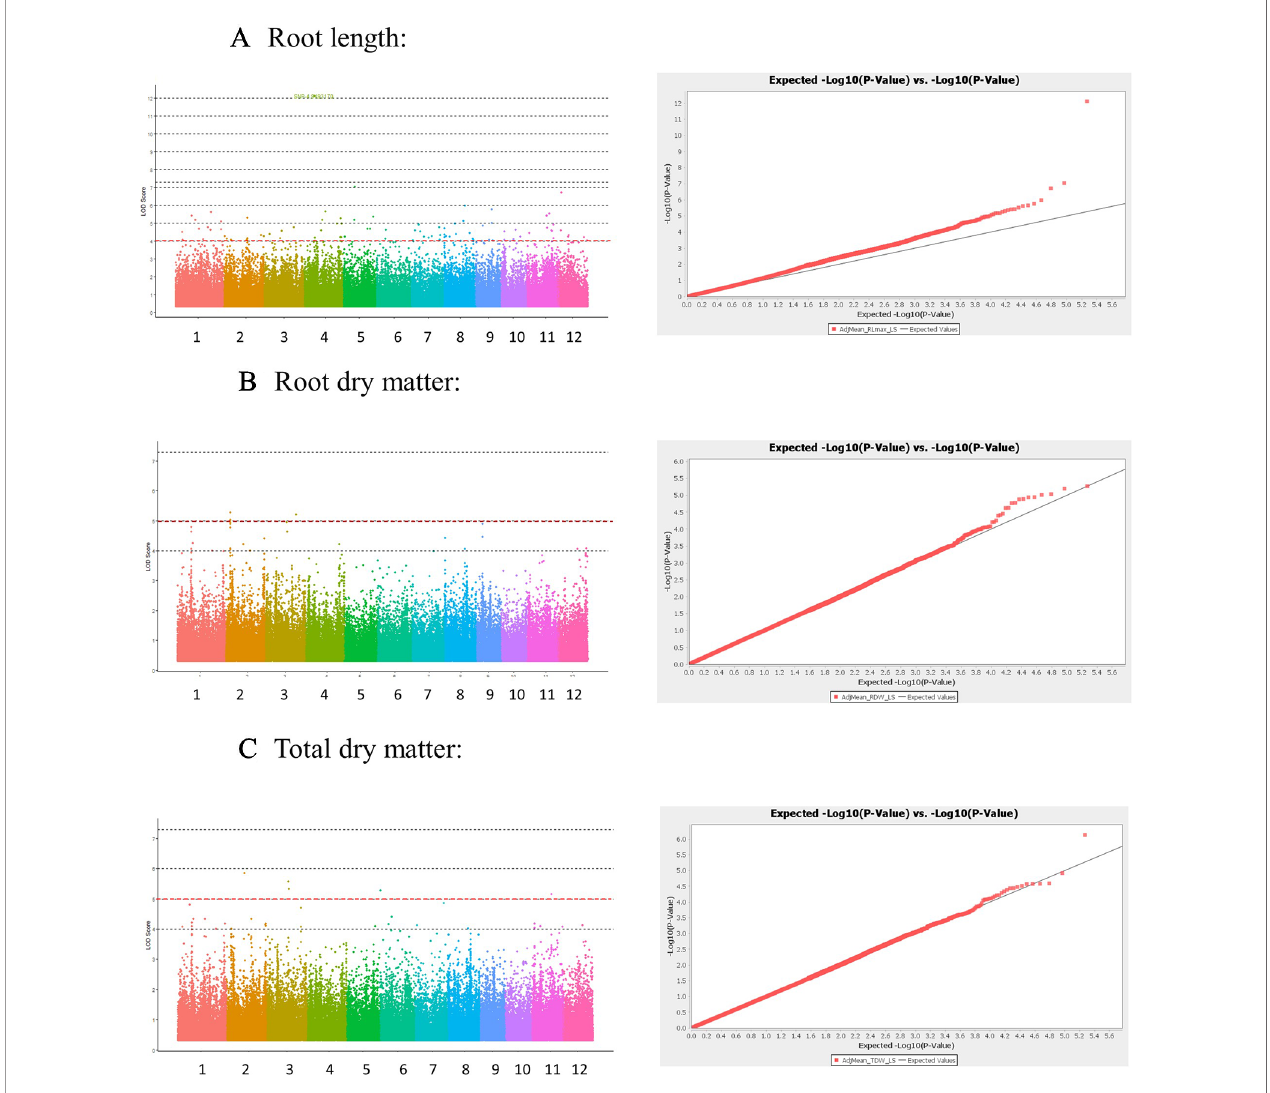
FIGURE 3 | Manhattan and Quantile-quantile (QQ) plots derived from GWAS analysis for traits: (A) Root length, (B) Root dry matter, and (C) total dry matter. Manhattan plot shows negative logarithmic ((-log10 ( P )) values of association for each SNP (Y axis), and SNP location along the 12 chromosomes (colored bar in X axis). Red line indicates a -log10 (P value) threshold of 5. QQ plots X shows the expected -log10 (p value) on X-axis, and measured -log10 (p value) on